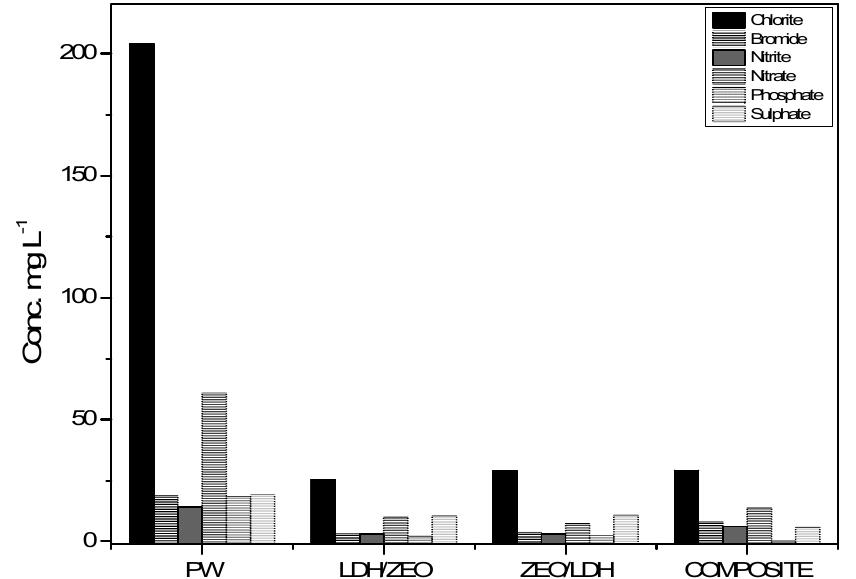
produced during treatment with the different treatments, as analysed by IC, are presented in Figure 6.